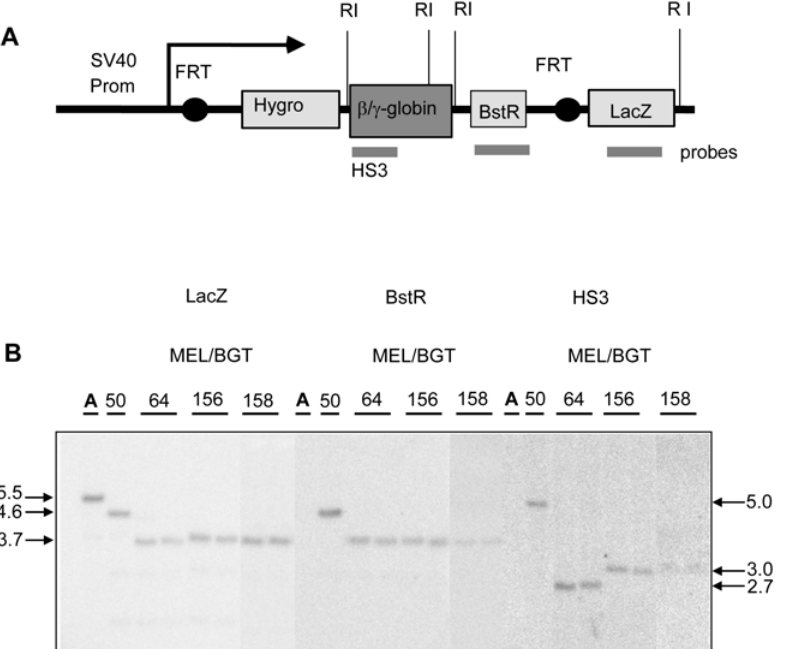
Figure 4. Single copy integration of LCR b / c -globin transgenes into a specific FRT site in MEL acceptor cells. (A) Structure of the transgene after targeted insertion in MEL cells showing the location of Eco RI (R1) restriction sites and the LacZ, BstR and HS3 probes (grey lines). MEL acceptor DNA is cut 3 9 of LacZ, and BGT50 is cut 3 9 of LacZ and once within the b / c -globin sequence. Two additional Eco RI sites were introduced in the 5 9 and 3 9 linkers during SFV vector subcloning of BGT64, BGT156, BGT158. (B) Southern blot analysis of genomic DNA cut with Eco RI. Hybridization with LacZ, BstR and HS3 probes confirms intactness of the integrated constructs. Hybridization with BstR and HS3 probes detects no band in the MEL acceptor cell line as expected, or a single band of the expected size for a single site transgene integration at the FRT site and the absence of random integrations.